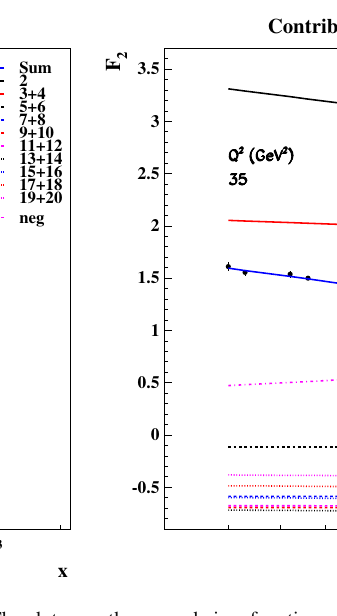
Fig. 14 Contributions to F 2 of individual eigenfunctions. The dots show the measured points at Q 2 = 6 . 5 and 35 GeV 2 , The full blue line shows the BFKL prediction at these Q 2 ’s, other lines show the con- tributions of eigenfunctions specified in the legend. With exception of